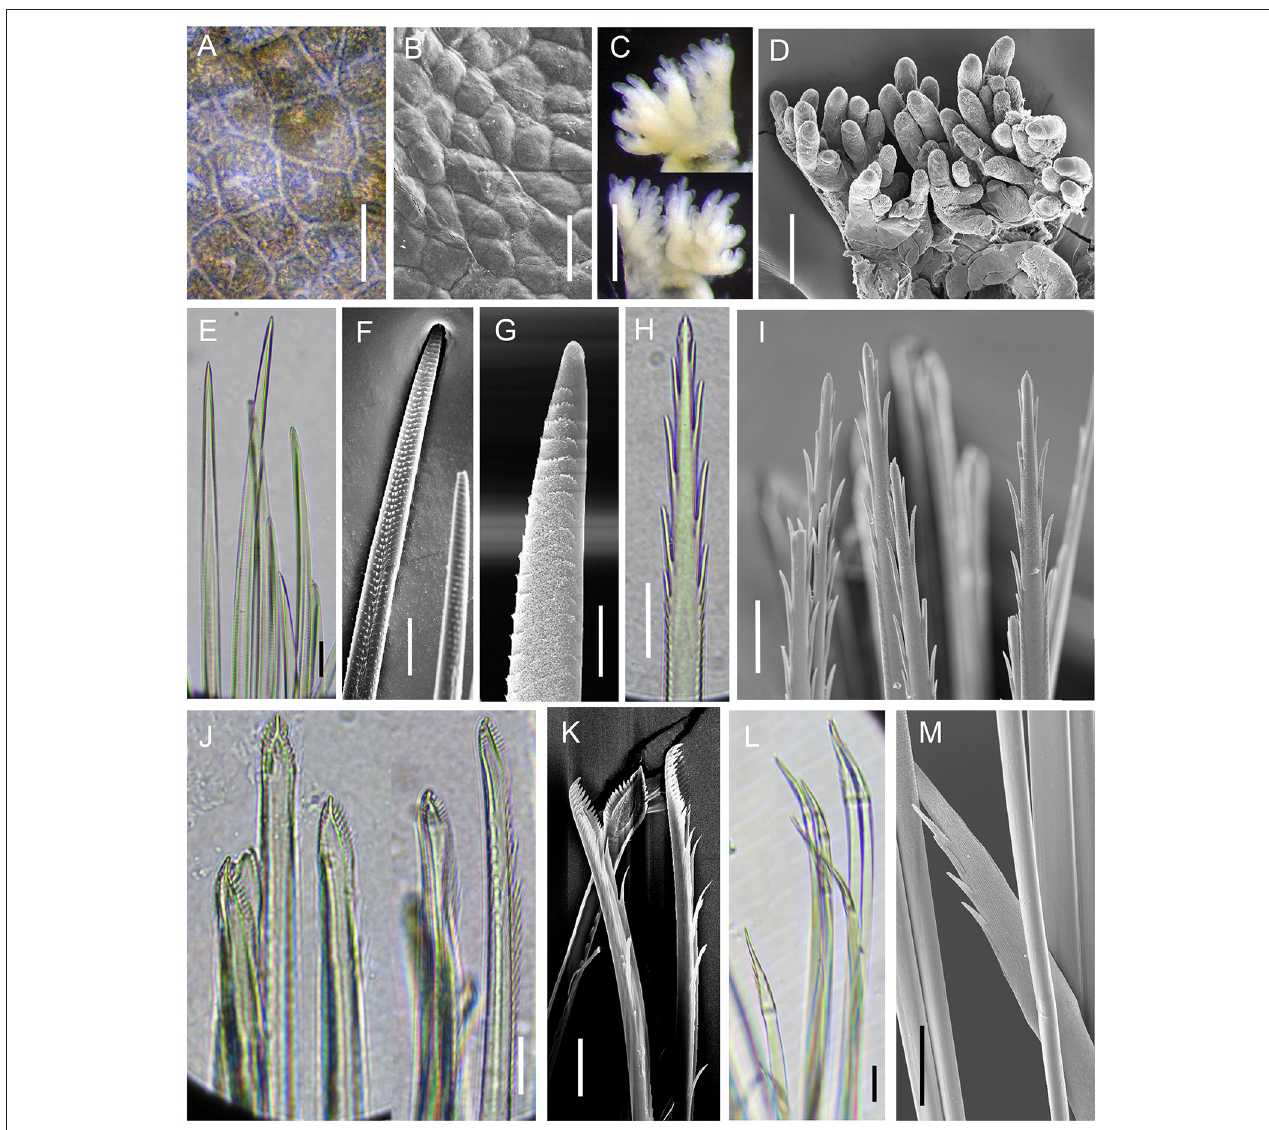
FIGURE 4 | Branchinotogluma japonicus. Details of scale and chaetae. (A–L) are from Specimen 1; (M,N) is from Specimen 5. (A,B) elytral surface. (C,D) branchiae on segment 11. (E–G) notochaetae and the details of tips. H and I, upper neurochaetae and the details of the tips. J and K, lower neurochaetae. (L,M) special chaetae from last parapodia. (C–K) are all from right segment 11 parapodium. Scale bar: (A,B,H,J,K,L,M) 20 µ m; (C) 500 µ m; (D) 100 µ m; (E,F,I) 30 µ m; (G) 10 µ